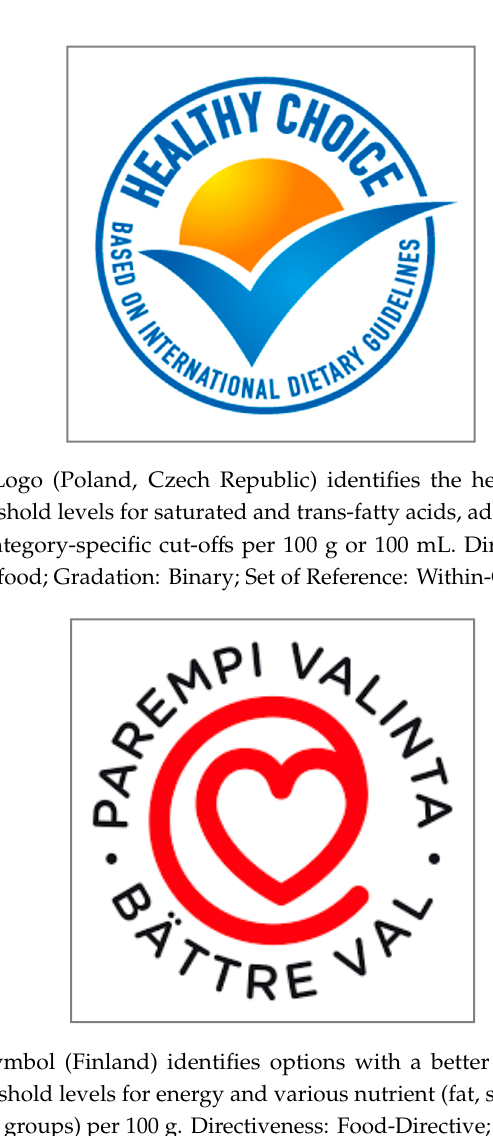
Gradation: Binary; Set of Reference: Within-Category; Sign: